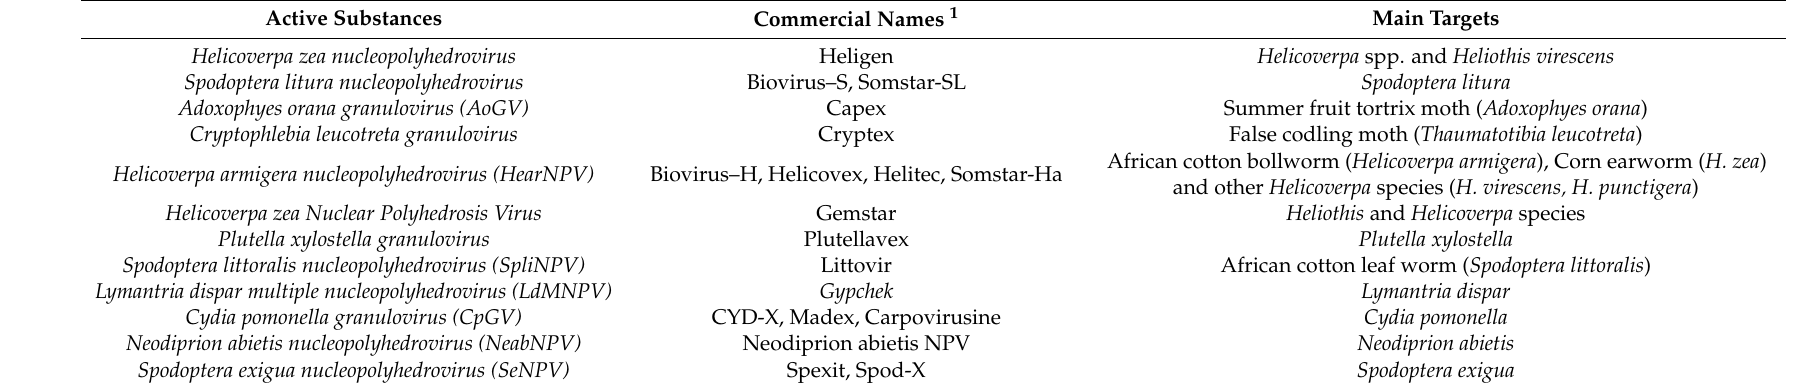
Table 3. Selection of commercial products based on entomopathogenic